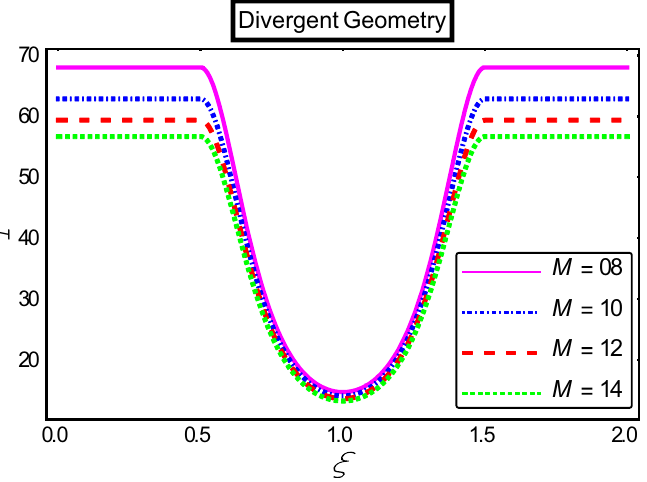
Figure 10. Impact of Hartmann numbers on the temperature profile.